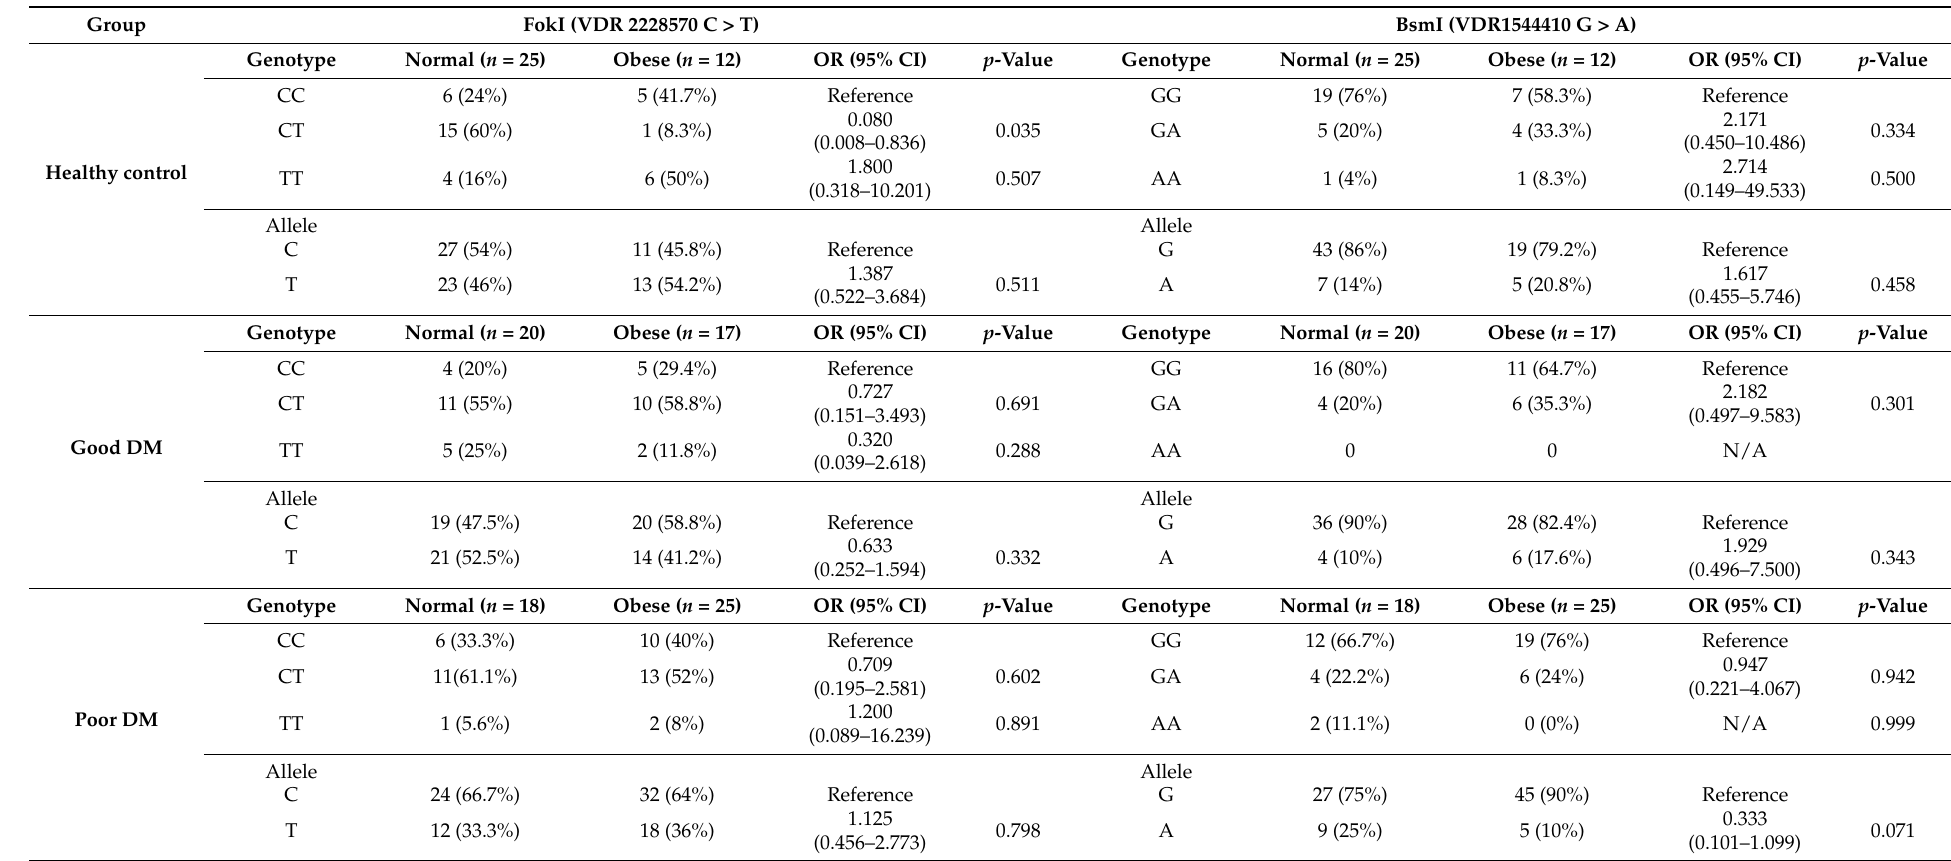
Table 9. Association between VDR polymorphism at FokI (VDR 2228570 C > T) and BsmI (VDR1544410 G > A) and risk of